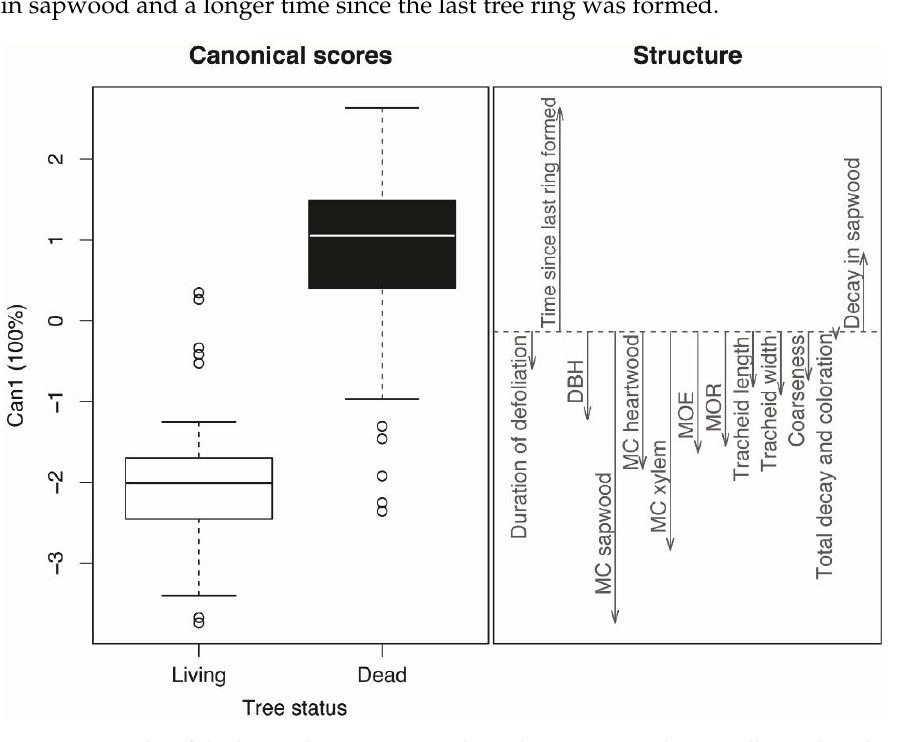
Figure 6. Results of the linear discriminant analysis that compares the overall wood quality patterns of trees visually classified as living of dead balsam firs (13 wood quality parameters). DBH: diameter at breast height, MC: moisture content, MOE: modulus of elasticity, MOR: modulus of